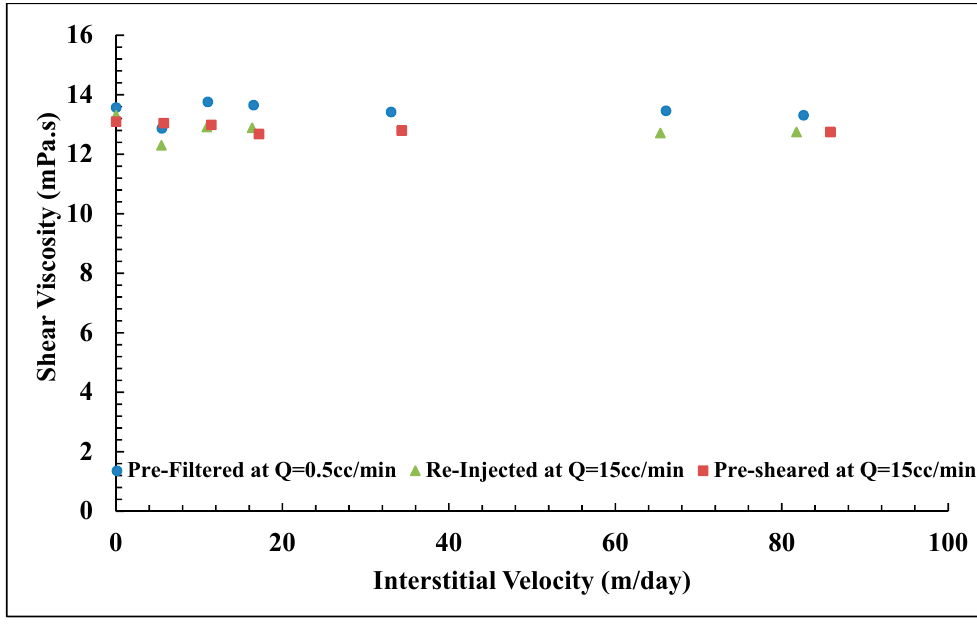
Figure 11. Effluent shear viscosity of Solution B measured at γ(cid:4662) = 10 s (cid:2879)(cid:2869) . Error bars are smaller than the size of each point (±0.20 mPa.s).